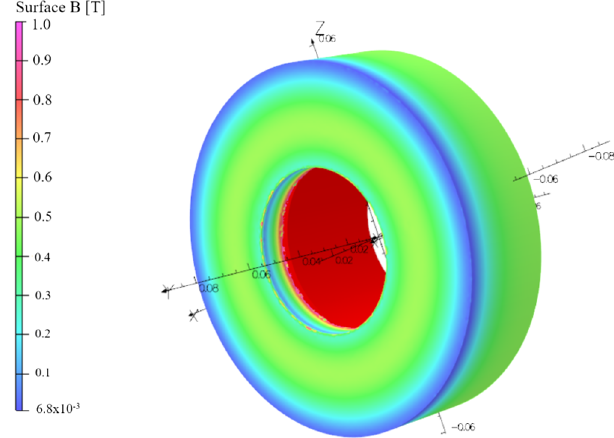
FIG. 6. Surface magnetic field produced by the solenoid (dimensions in